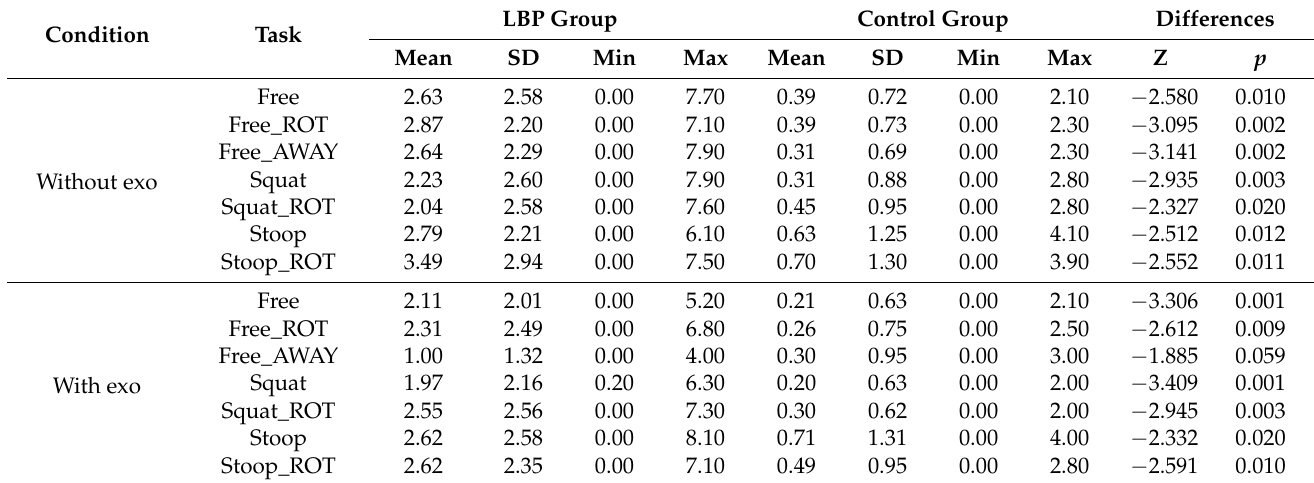
Table 1. Summary of local low back pain score